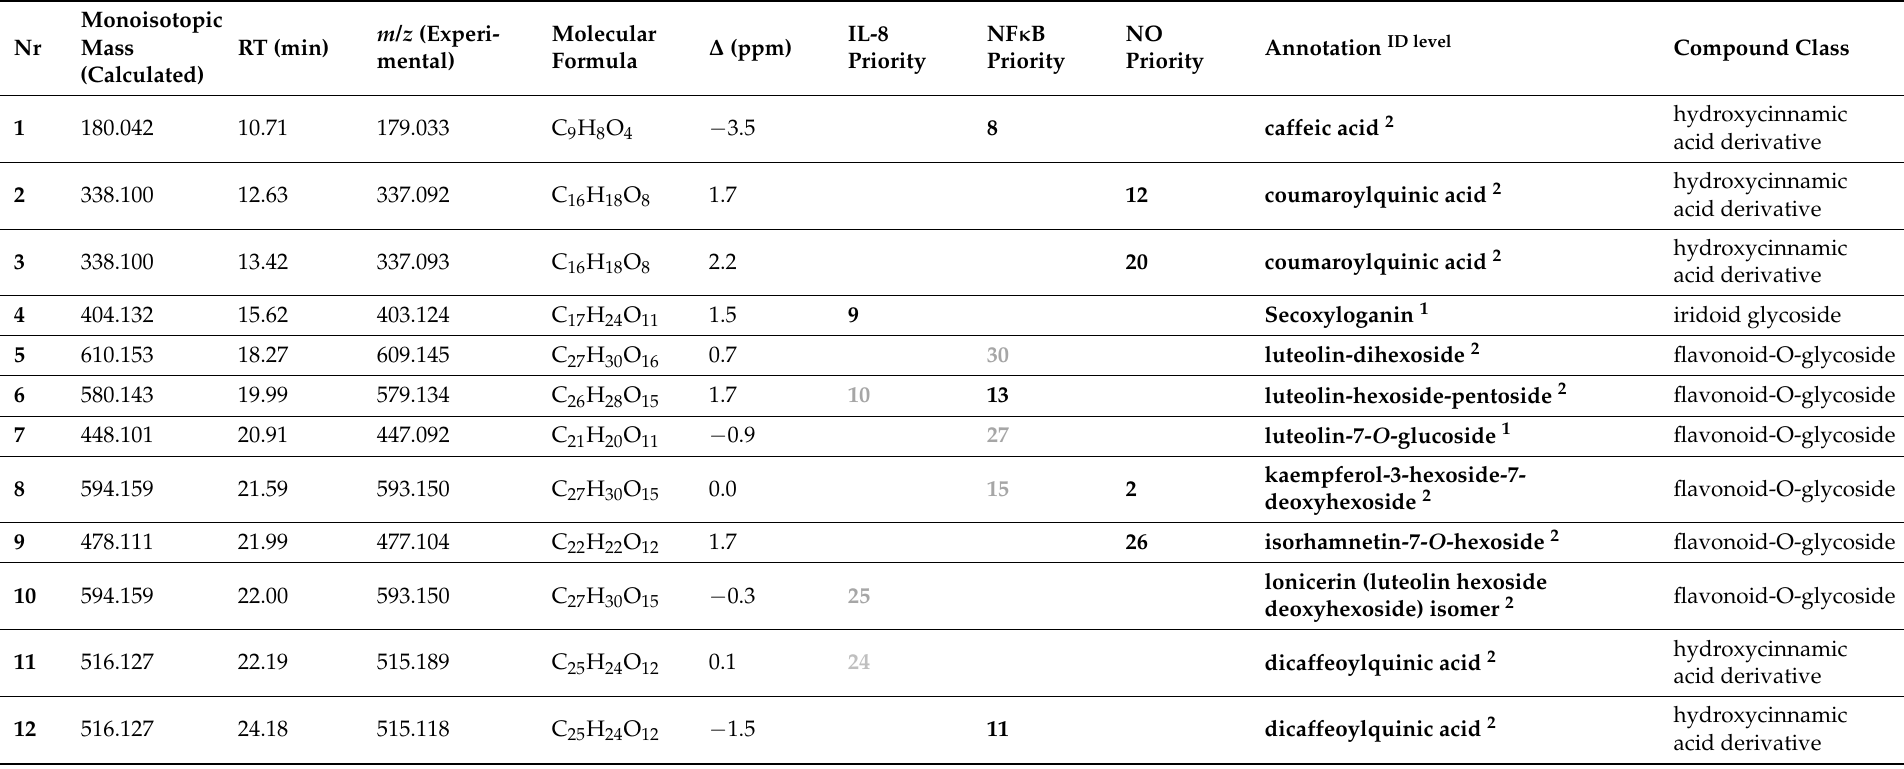
Table 2. List of annotated OPLS-DA candidates; compounds written in italics were isolated from L. hypoglauca , and their structures were elucidated fully or partially by NMR spectroscopy (Section 2.4); priority: deduced from S-plots of respective OPLS-DA models; low number represents high priority; numbers written in gray represent candidates with low levels of reliability (jackknife-based confidence interval, including 0); annotation: phospholipid and sphingolipid nomenclature, see Reference [18], fragmentation patterns and identification sources and Supplementary Table S4. ID level ([19,20]): 0 , isolated pure compound, unambiguous 3D structure; 1 , confident 2D structure, identified by reference standard match (retention time and MS/MS); 2 , tentative annotation by comparison of structural formula and MS/MS fragmentation pattern with data from databases or literature. 3 , no data available in literature or databases; compound tentatively assigned on the basis of the MS/MS fragmentation pattern (theoretical interpretation and/or comparison to related